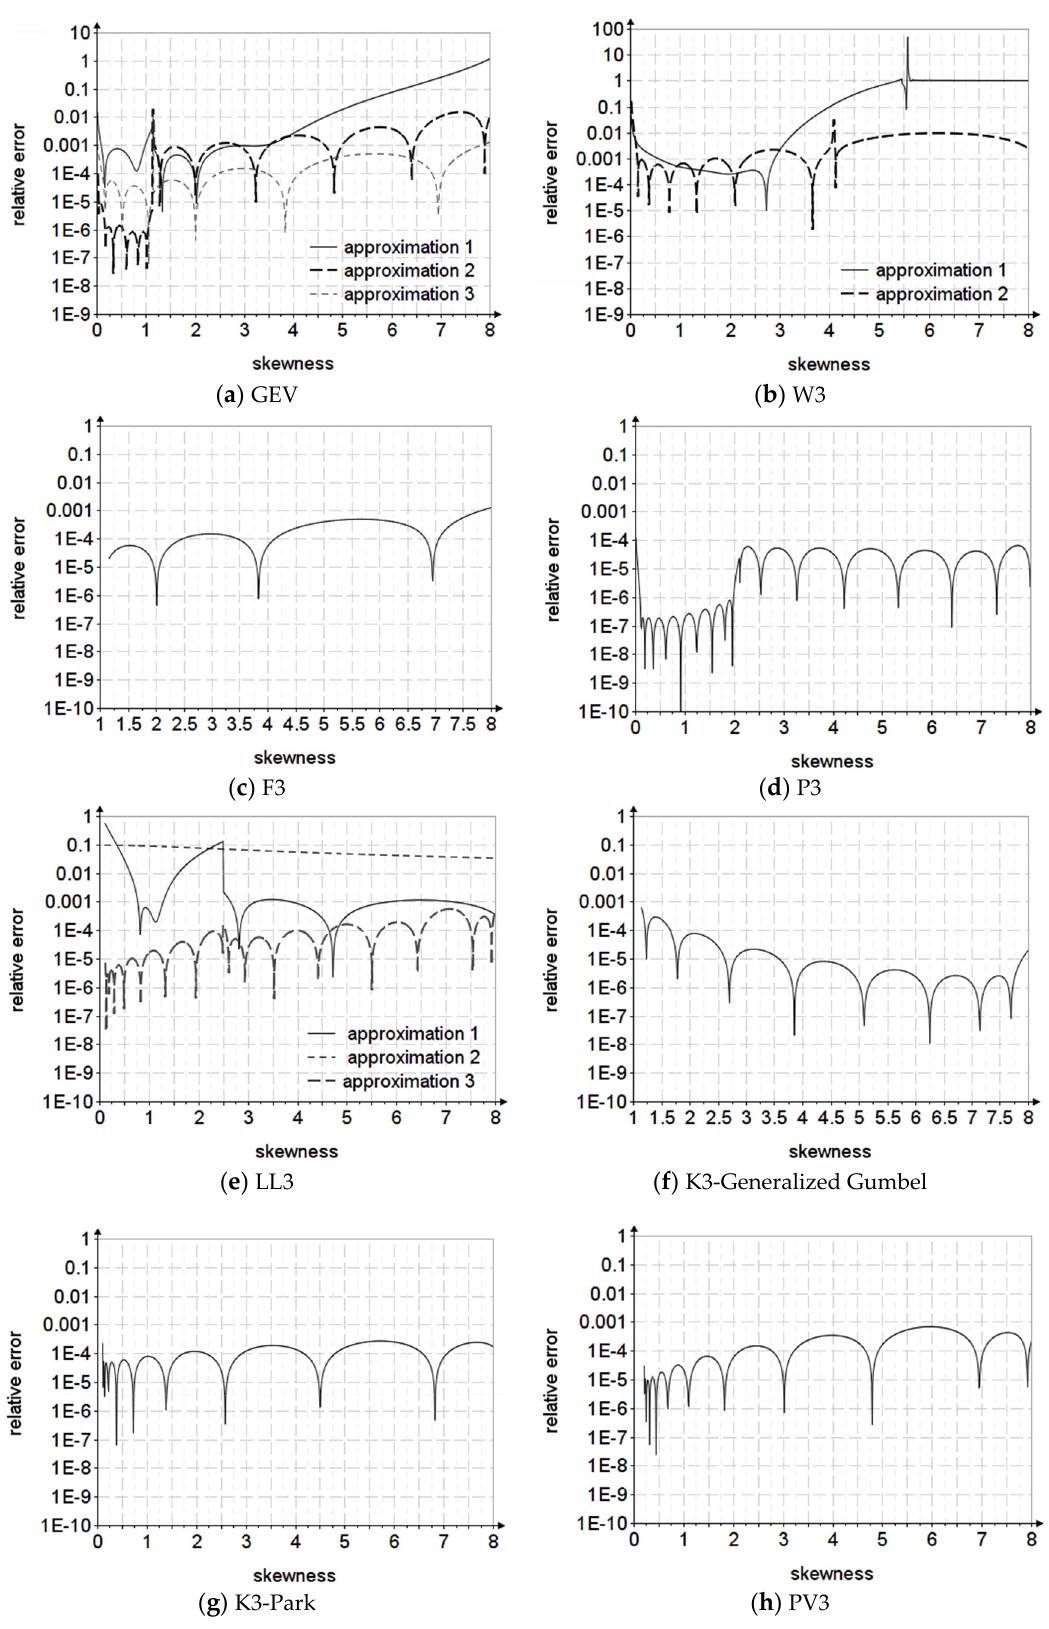
Figure 4. The variation of errors depending on C s